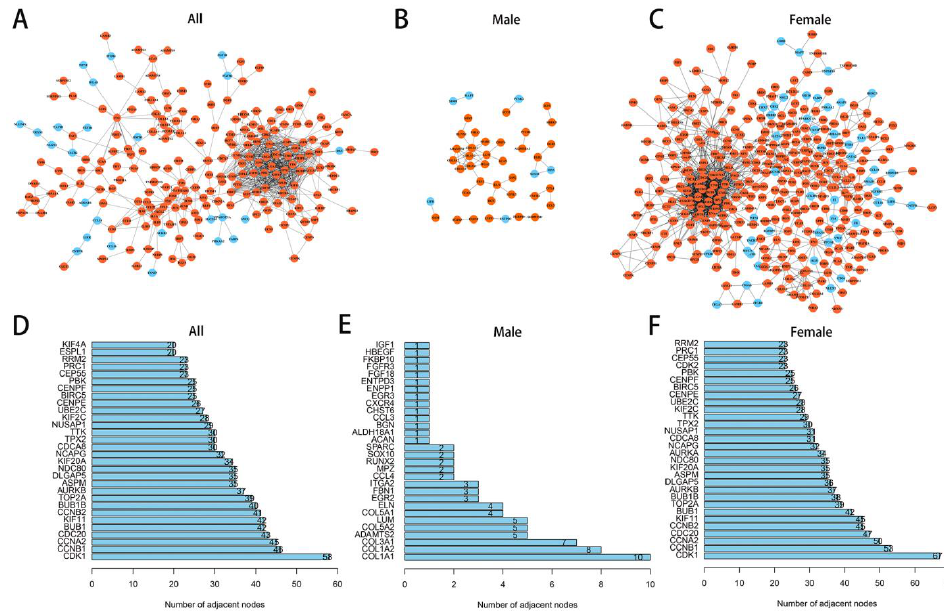
Figure 7. Protein – protein interaction (PPI) network and hub genes in different sex. ( A ) PPI network in AVF patients. ( B ) PPI network in male AVF patients. ( C ) PPI network in female AVF patients. ( D ) Hub genes in AVF patients. ( E ) Hub genes in male AVF patients. ( F ) Hub genes in female AVF patients.